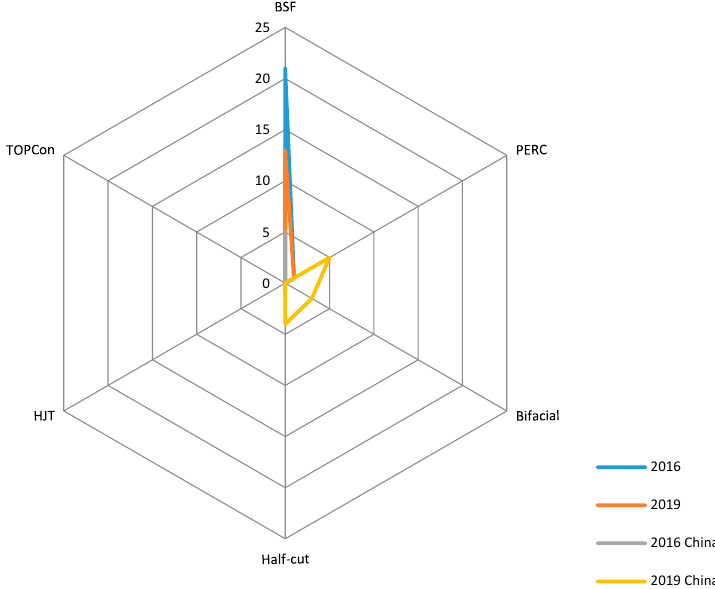
Figure 15. Numberofcompaniesinthesampleofferingselectedtechnologies—monoc-Simodulecategory. Energies 2020 , 13 , x FOR PEER REVIEW Figure 15. Number of companies in the sample offering selected technologies—mono c-Si module category.